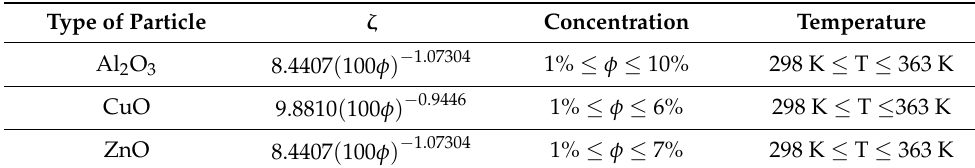
Table 2. Empirical constants for different types of nanoparticles and concentrations with a tempera- ture range of 298 K ≤ T ≤ 363